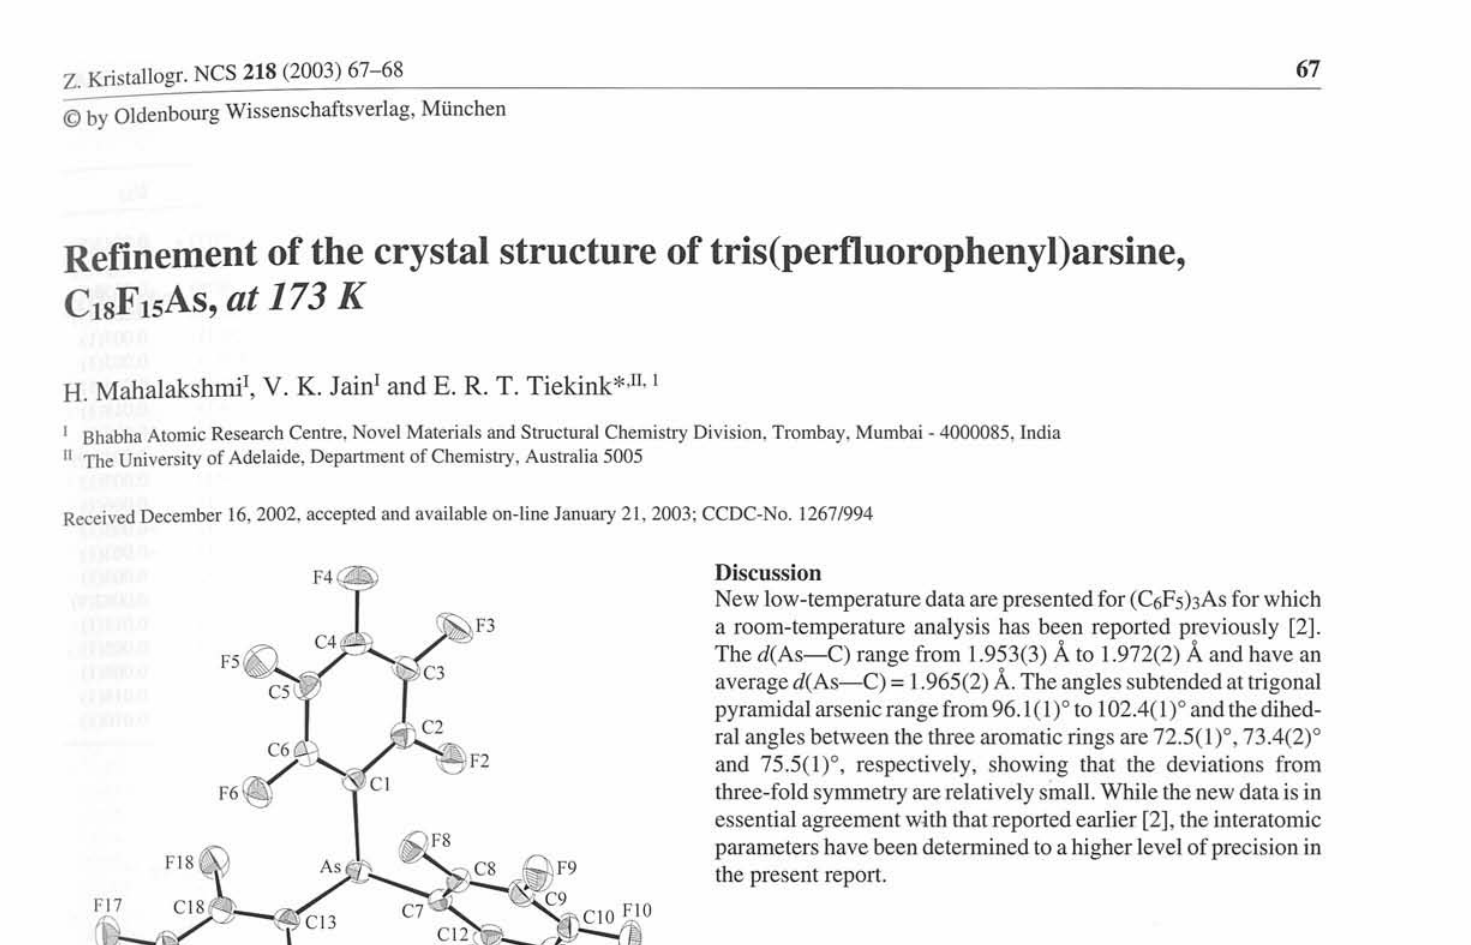
Table 1. Data collection and handling. Crystal: